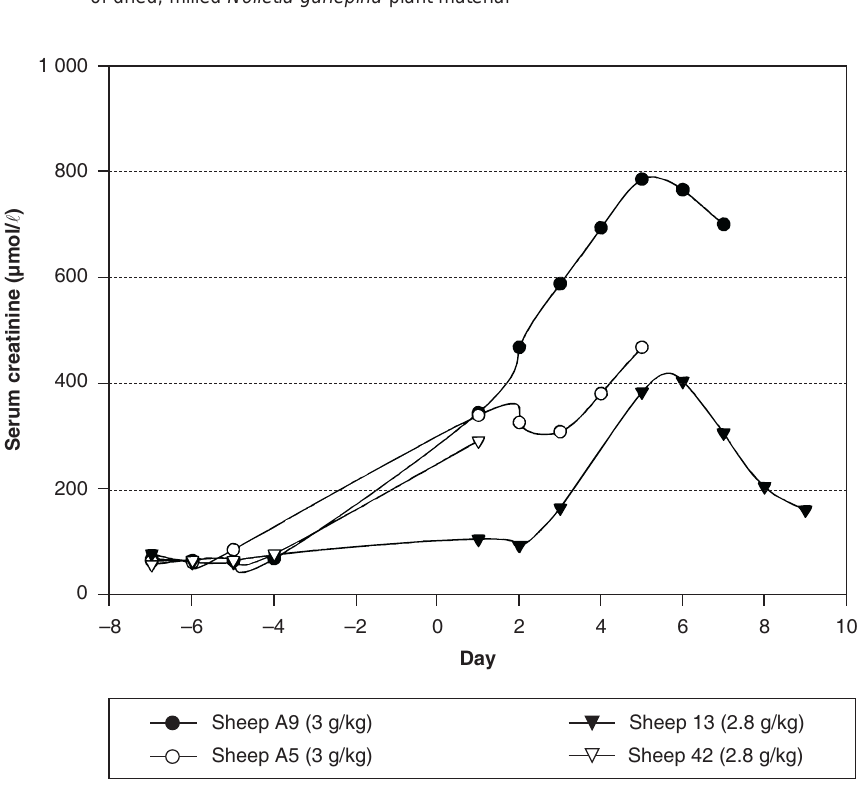
FIG. 2 Serum creatinine concentration in four sub-acutely affected sheep following adminis- tration of dried, milled Nolletia gariepina plant